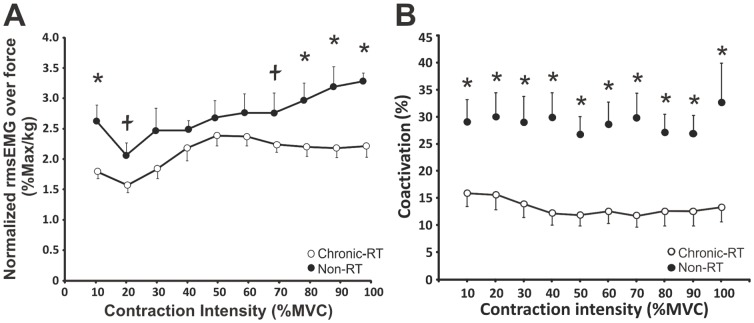
Biceps brachii activation during muscle contraction from 10–100% MVC.(A) Normalized rmsEMG to absolute elbow flexion forces recorded from 10–100%MVC. (B) Muscle coactivation (EMG of triceps:biceps brachii) 10–100% MVC. Each data point represents group means ± SE. * Indicates a significant (p≤0.041 and p<0.001 for activation and coactivation, respectively) difference between groups. Ł Indicates a trend (p≤0.075) for between group differences.